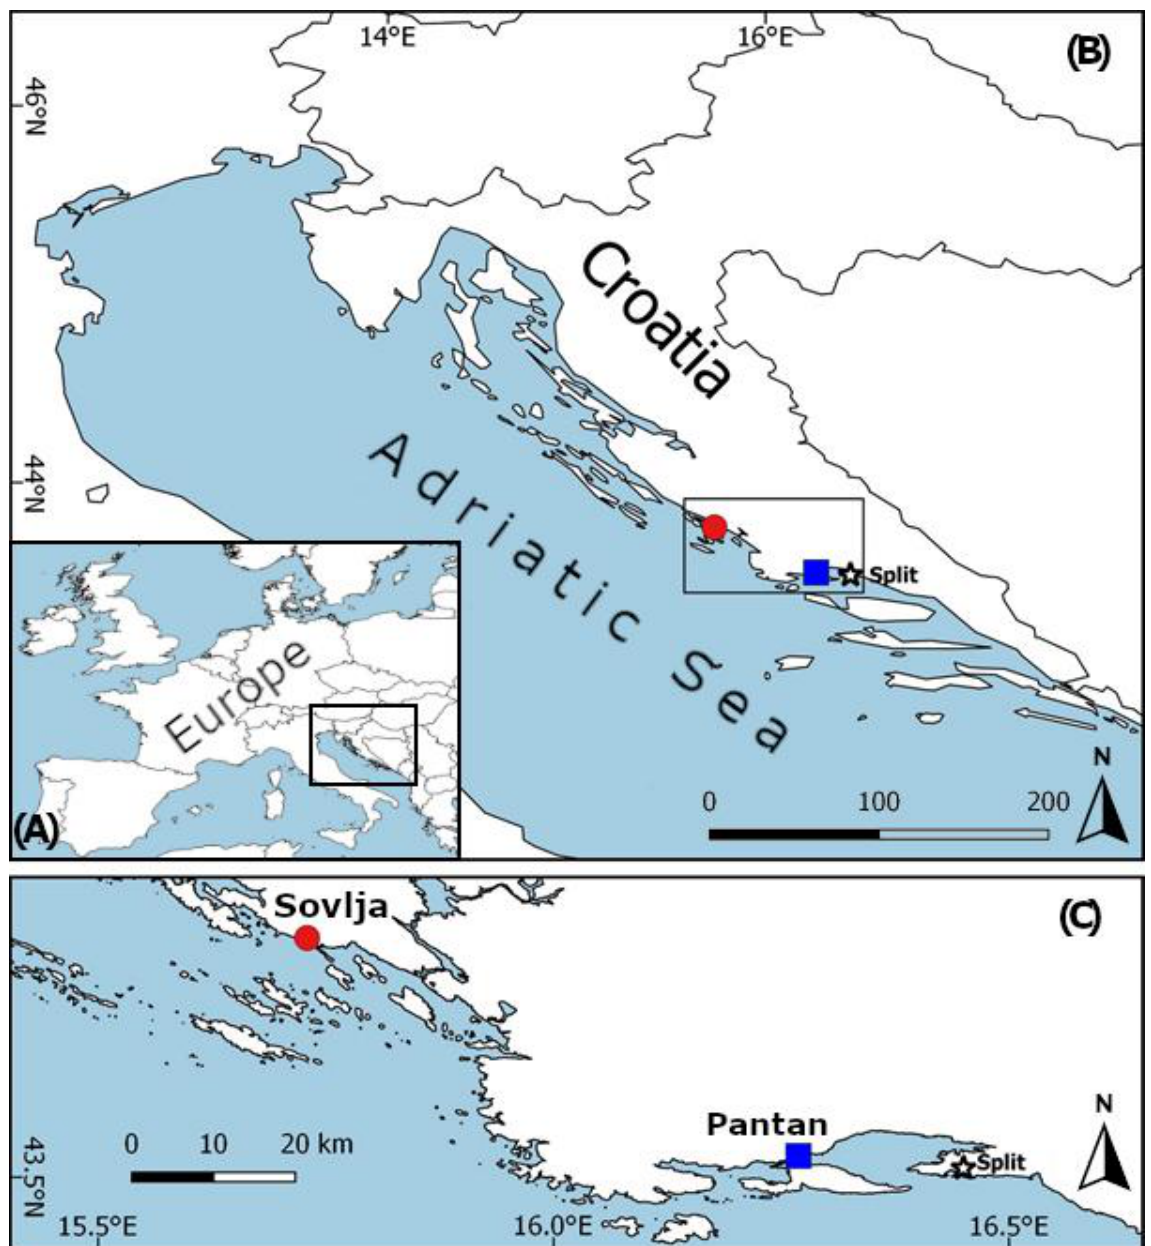
Figure 1. Sampling area in the Europe ( A ) along the eastern Adriatic coast ( B ) with selected sites: Pantan (square) and Sovlja (circle) ( C ).